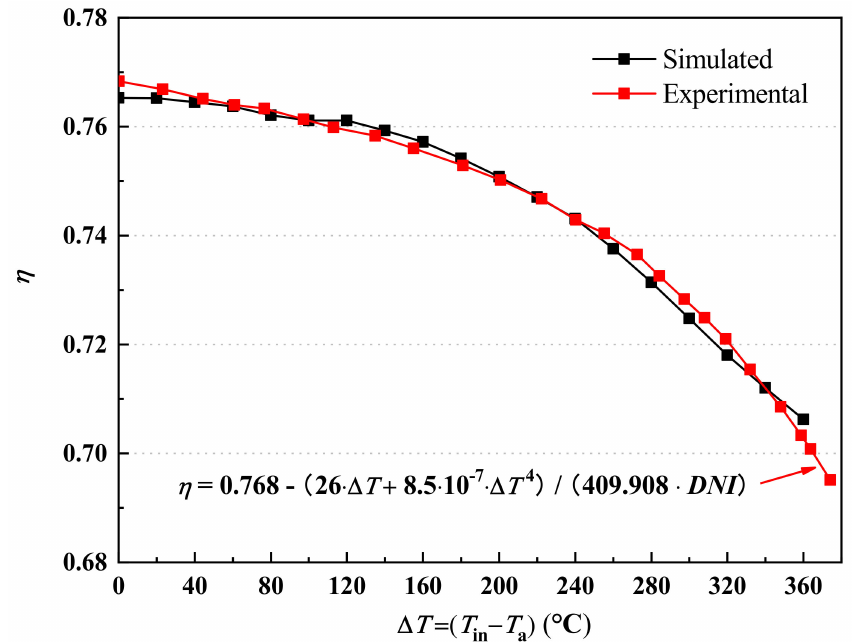
Figure 5. Modeled energetic e ffi ciency versus experimental